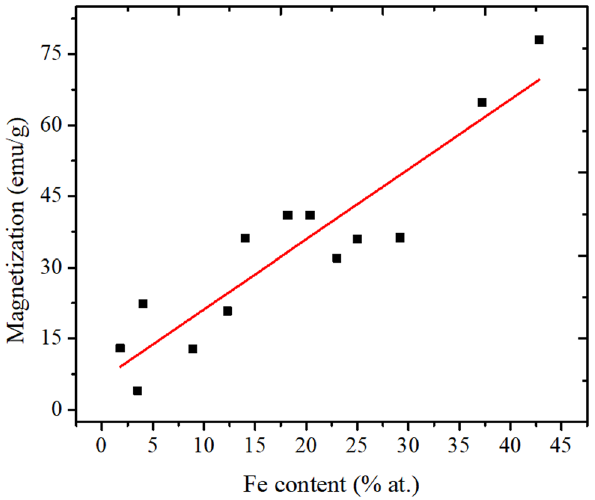
Figure 8: E ff ect of the iron content on saturation magnetization in montmorillonite - based MICNCs.